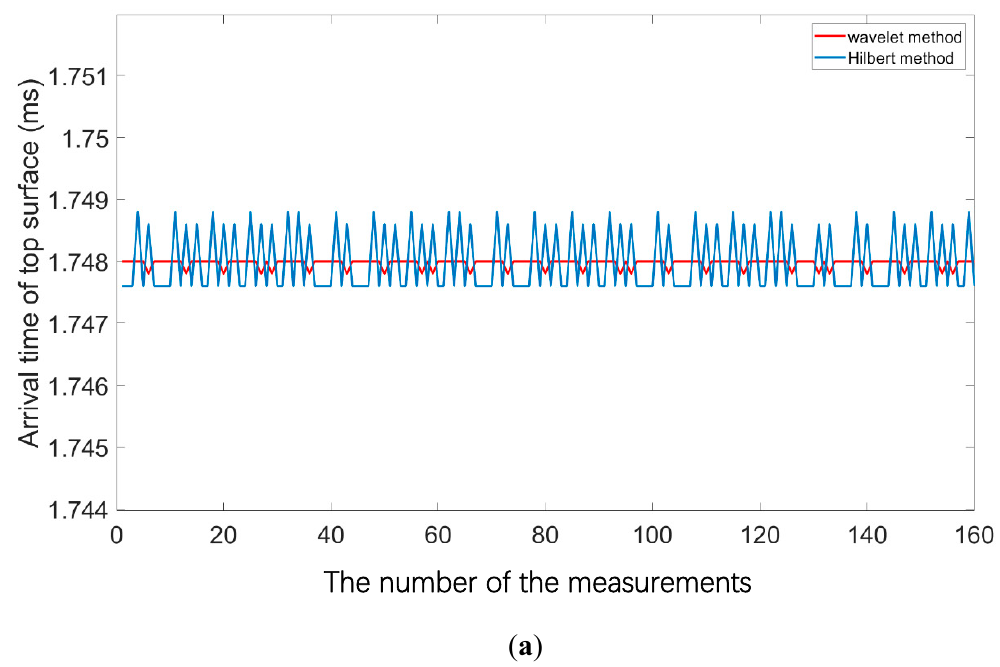
13 of 22 Figure 5. The dual-channel signal of 100th record and the comparison of different envelope extraction